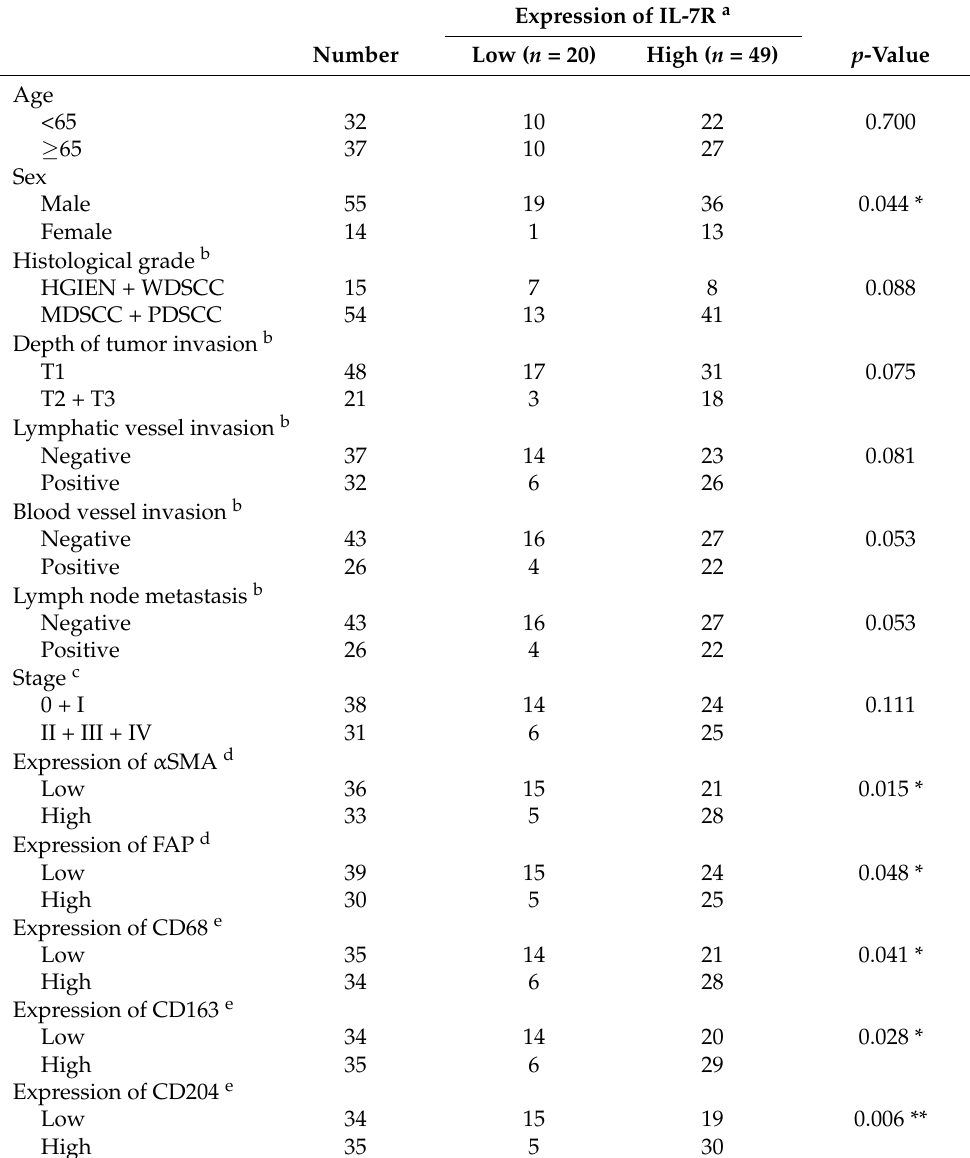
Table 1. Relationship between IL-7R expression levels and clinicopathological factors in human esophageal squamous cell carcinoma